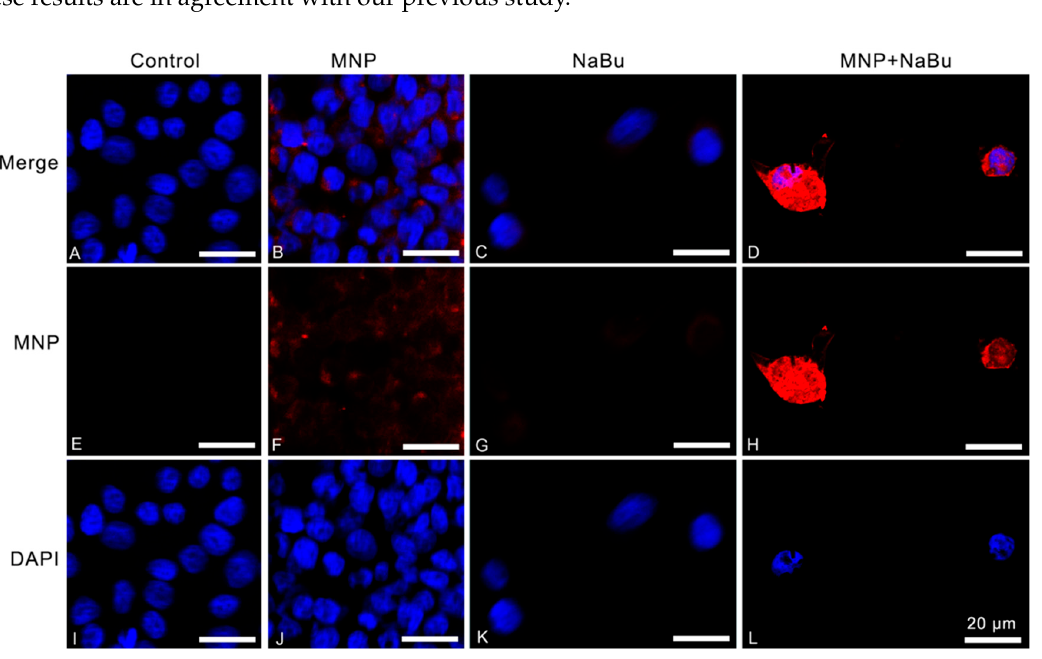
Figure3. LoVocellsincubatedwithrhodamine-conjugatedFA-PEG@MNPsand / orNaBu. ( A ):LoVocells Figure 3. LoVo cells incubated with rhodamine ‐ conjugated FA ‐ PEG@MNPs and/or NaBu. ( A ): LoVo not exposed to FA-PEG@MNPs and / or NaBu (negative control). ( B – D ): LoVo cells incubated with cells not exposed to FA ‐ PEG@MNPs and/or NaBu (negative control). ( B – D ): LoVo cells incubated MNPs, NaBu, and MNPs + NaBu, respectively. Red, and blue signals are due to rhodamine-conjugated with MNPs, NaBu, and MNPs + NaBu, respectively. Red, and blue signals are due to FA-PEG@M, and to DAPI stained nuclei, respectively ( E – H ): the same images shown in A, B, C, and D, rhodamine ‐ conjugated FA ‐ PEG@M, and to DAPI stained nuclei, respectively ( E – H ): the same images respectively, showing only the red fluorescence due to MNPs. ( I – L ): the same images shown in A, B, C, shown in A, B, C, and D, respectively, showing only the red fluorescence due to MNPs. ( I – L ): the and D, respectively, showing only the blue fluorescence of DAPI staining the cell nuclei. Images were same images shown in A, B, C, and D, respectively, showing only the blue fluorescence of DAPI acquired with a Confocal Laser Scanning Microscopy using 405 and 555 nm wavelength lasers to detect staining the cell nuclei. Images were acquired with a Confocal Laser Scanning Microscopy using 405 the cell nucleus and the FA-PEG@MNPs, respectively. Scale bar: 20 µ and 555 nm wavelength lasers to detect the cell nucleus and the FA ‐ PEG@MNPs, respectively. Scale bar: 20 μ m.